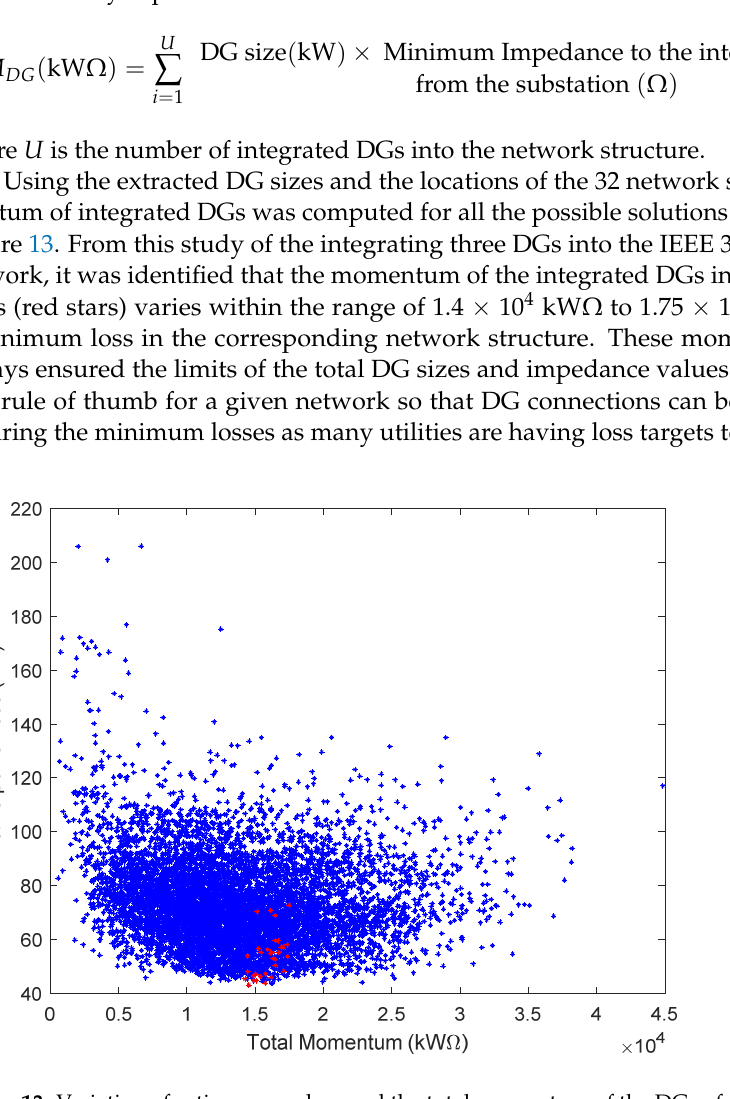
Figure 13. Variation of active power loss and the total momentum of the DGs of all possible solutions in every network structure.